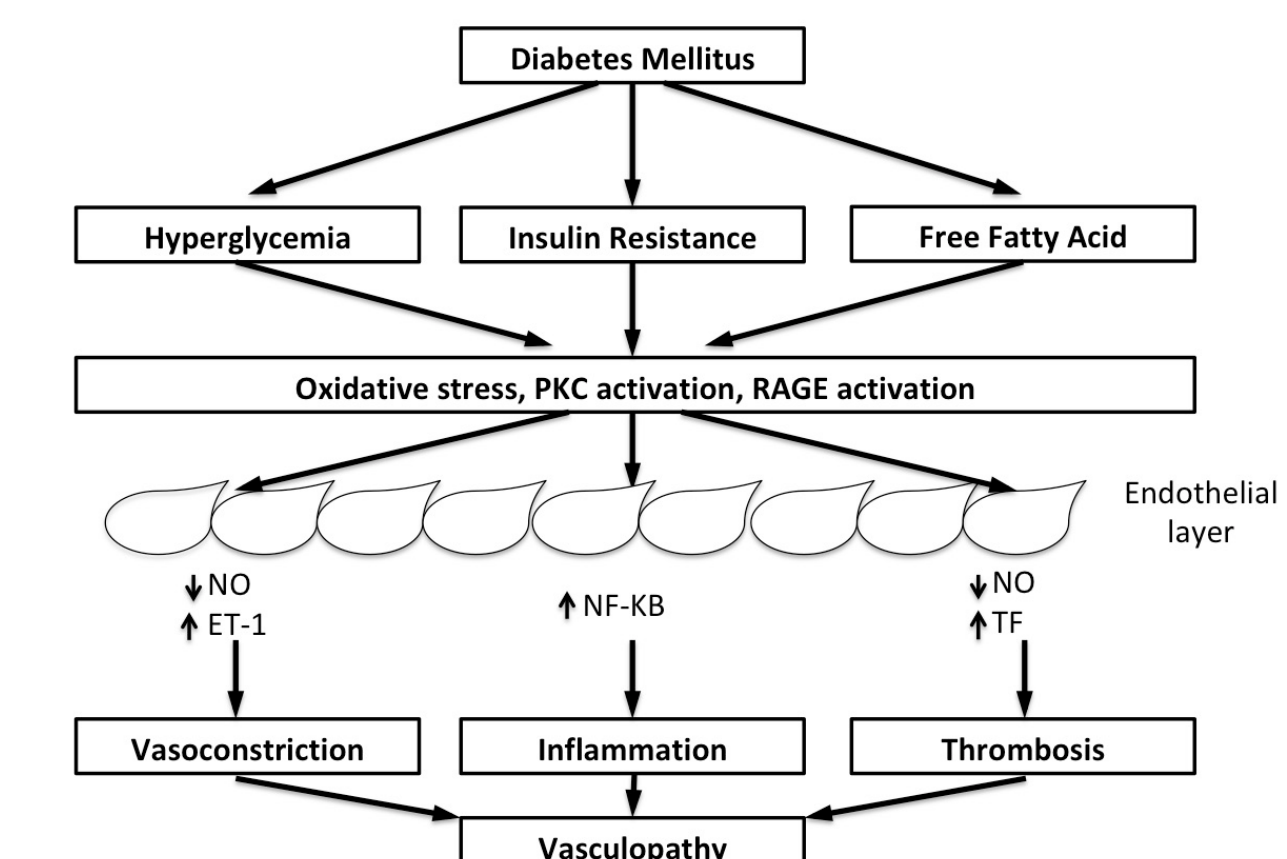
FIGURE 1 - The metabolic abnormalities that characterize diabetes, particularly hyperglycemia, insulin resistance, and free fatty acids, act to stimulate molecular mechanisms that change the function and structure of blood vessels. These include increased oxidative stress, disturbances of intracellular signal transduction (activation of protein kinase C [PKC]), and activation of receptors for advanced glycation end product (RAGE). Consequently, there is decreased availability of NO, increased production of endothelin (ET-1), activation of transcription factors such as NF- κ B, and production of prothrombotic factors such as tissue factor